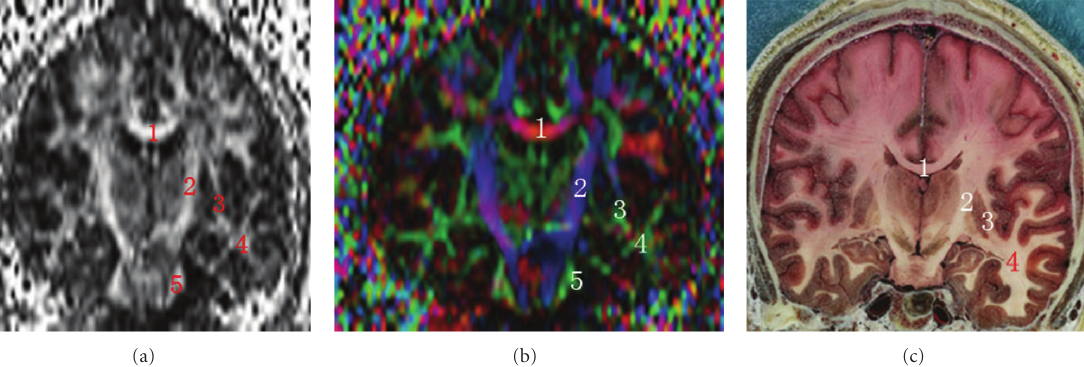
Figure 2: Coronal FA map, color tensor map, and sectional image of visible human at the posterior limb of internal capsule. (1) Body of corpus callosum, (2) pyramidal tract, (3) external capsule and extreme capsule, (4) inferior longitudinal fasciculus, and (5) middle cerebellar peduncle.